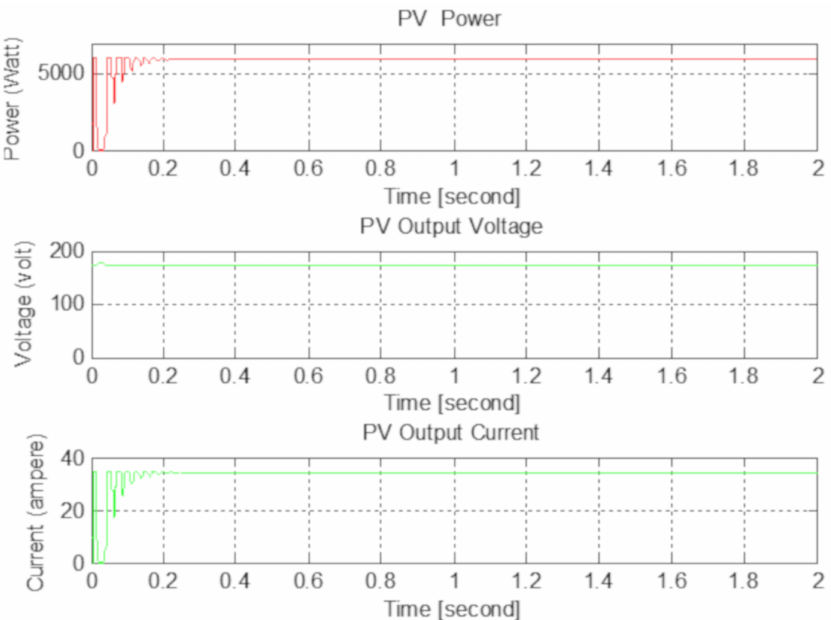
Figure 10. Simulation result of the PV power with MPPT, output voltage, output current.